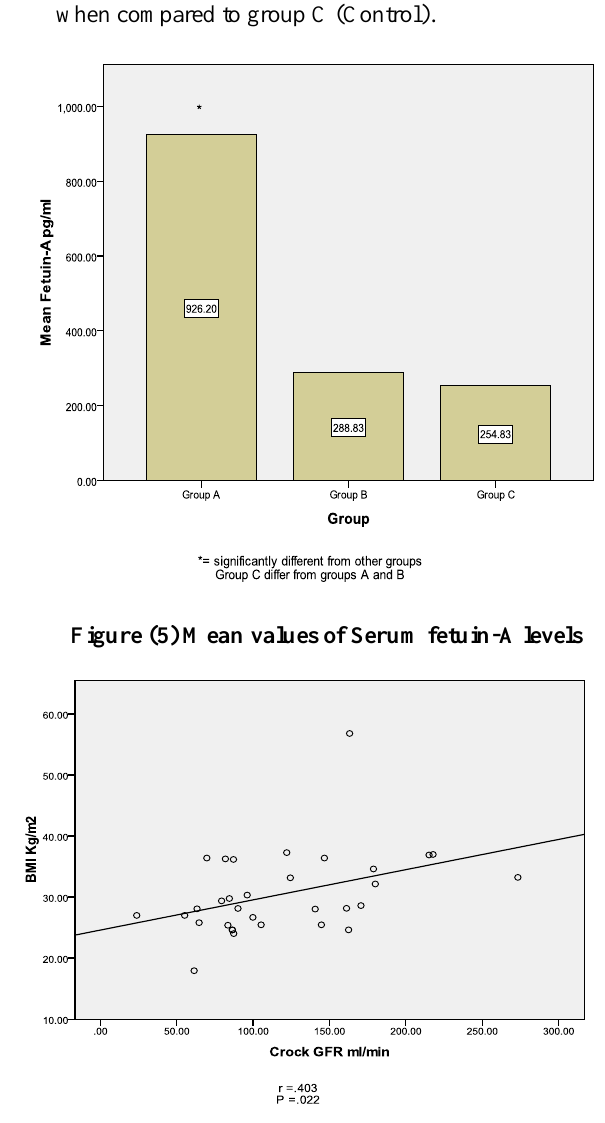
Figure (8) Significant correlation between chloride and fetuin-A in group B. Whereas, Pearson’s correlation coefficient values of 0.431and P value 0.022 indicating significant correlation between serum sodium and fetuin-A in non-albuminuric diabetics, as presented in